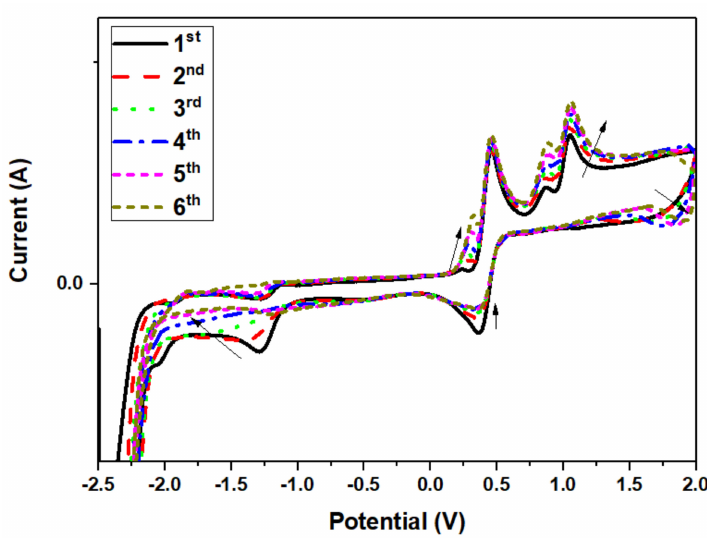
Figure 5. Cyclic voltammograms of PPL9: six consecutive scans at scan rate 100 mV · s − 1 . For PPL9, several oxidation and reduction processes can be observed in cyclic voltam- mogram. Apart from an onset of the oxidation process at 0.96 V, four maxima were distin- guished at − 1.25 V, 0.26 V, 0.88 V, and 1.05 V. On the other hand, the reduction process exhibited reduction offset at − 2.05 V, and two noticeable maxima—at − 1.35 V and 0.35 V. Taking the molecular structure of imine the processes observed at − 1.25 V and 1.35 V corresponding to oxidation and reduction were assigned to pyridine unit. Lucio et al.